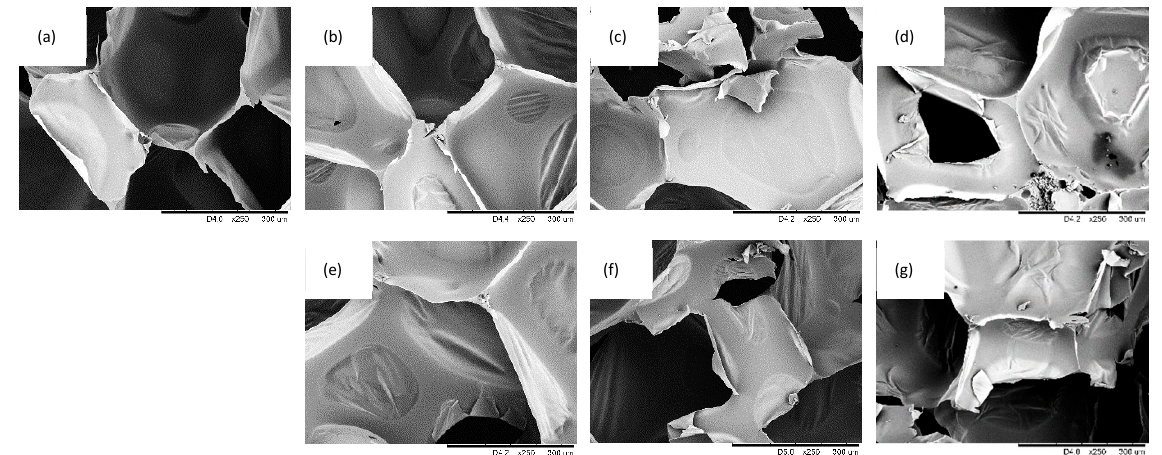
Figure 7. SEM images of ( a ) PUR-0, ( b ) PUR-SO-1, ( c ) PUR-SO-2, ( d ) PUR-SO-5, ( e ) PUR-SO/MTM-1, ( f ) PUR-SO/MMT-2, ( g )